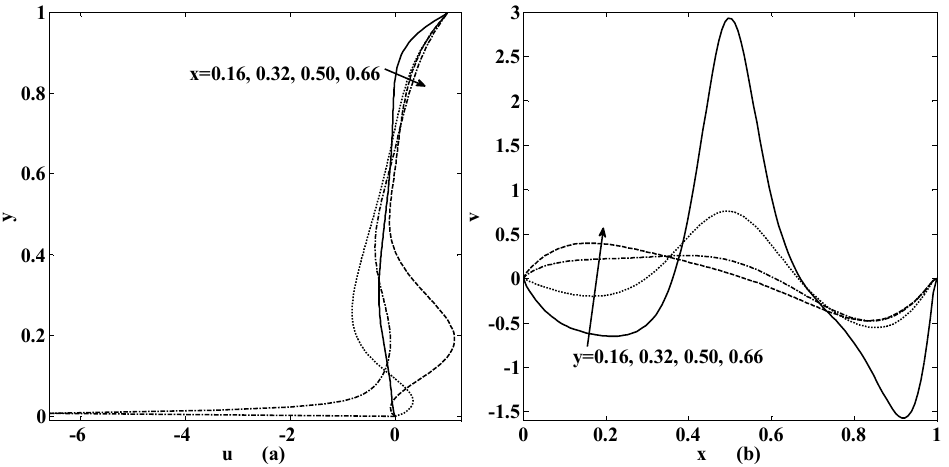
Figure 8. Variation of velocity ( a ) ),( yxu ; ( b ) ),( yxv , at the different positions in the cavity as within the figure if mentioned within the figure if